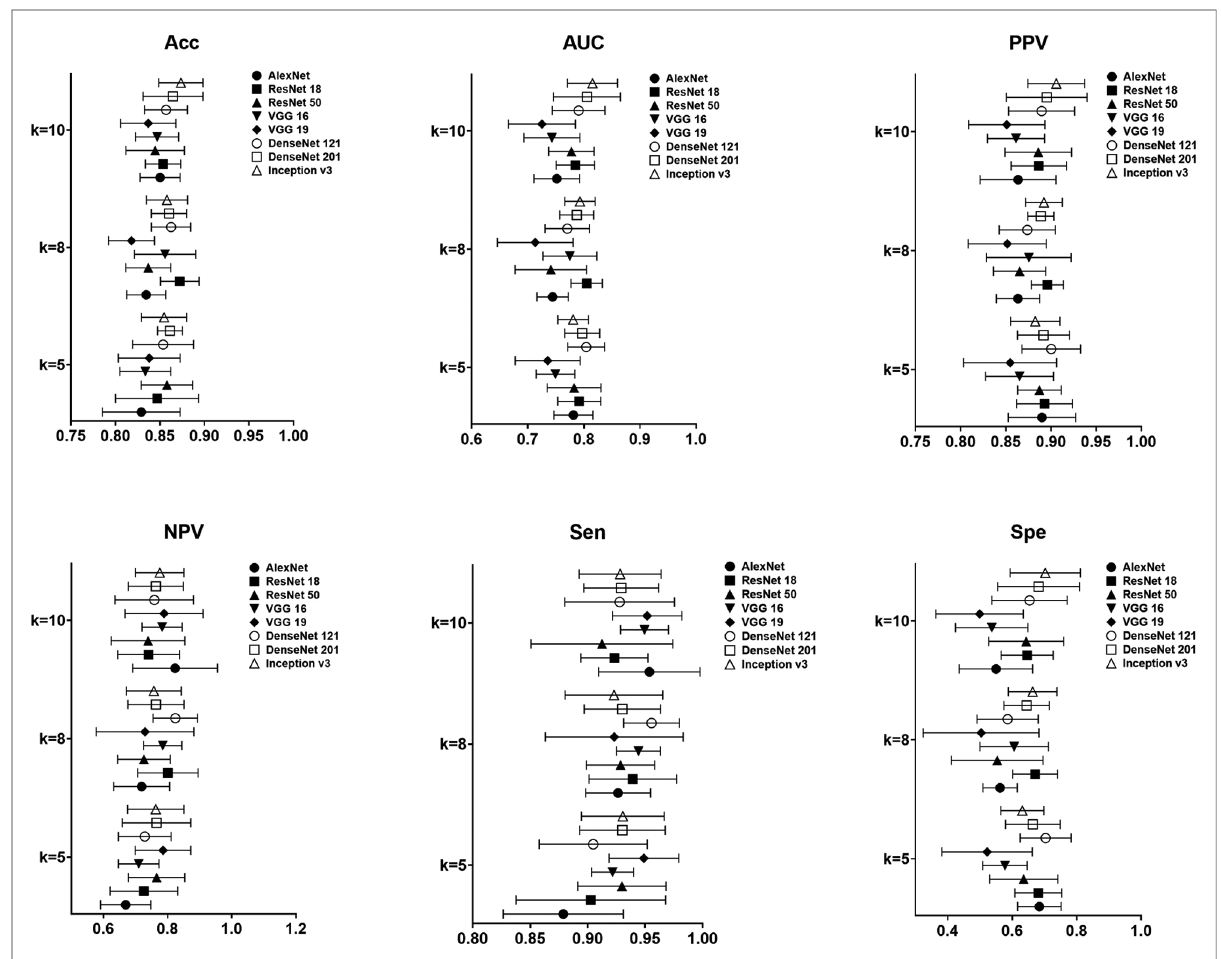
FIGURE 4 Result of performance metrics for the proposed 8 models in CAP detection for different k-folds cross